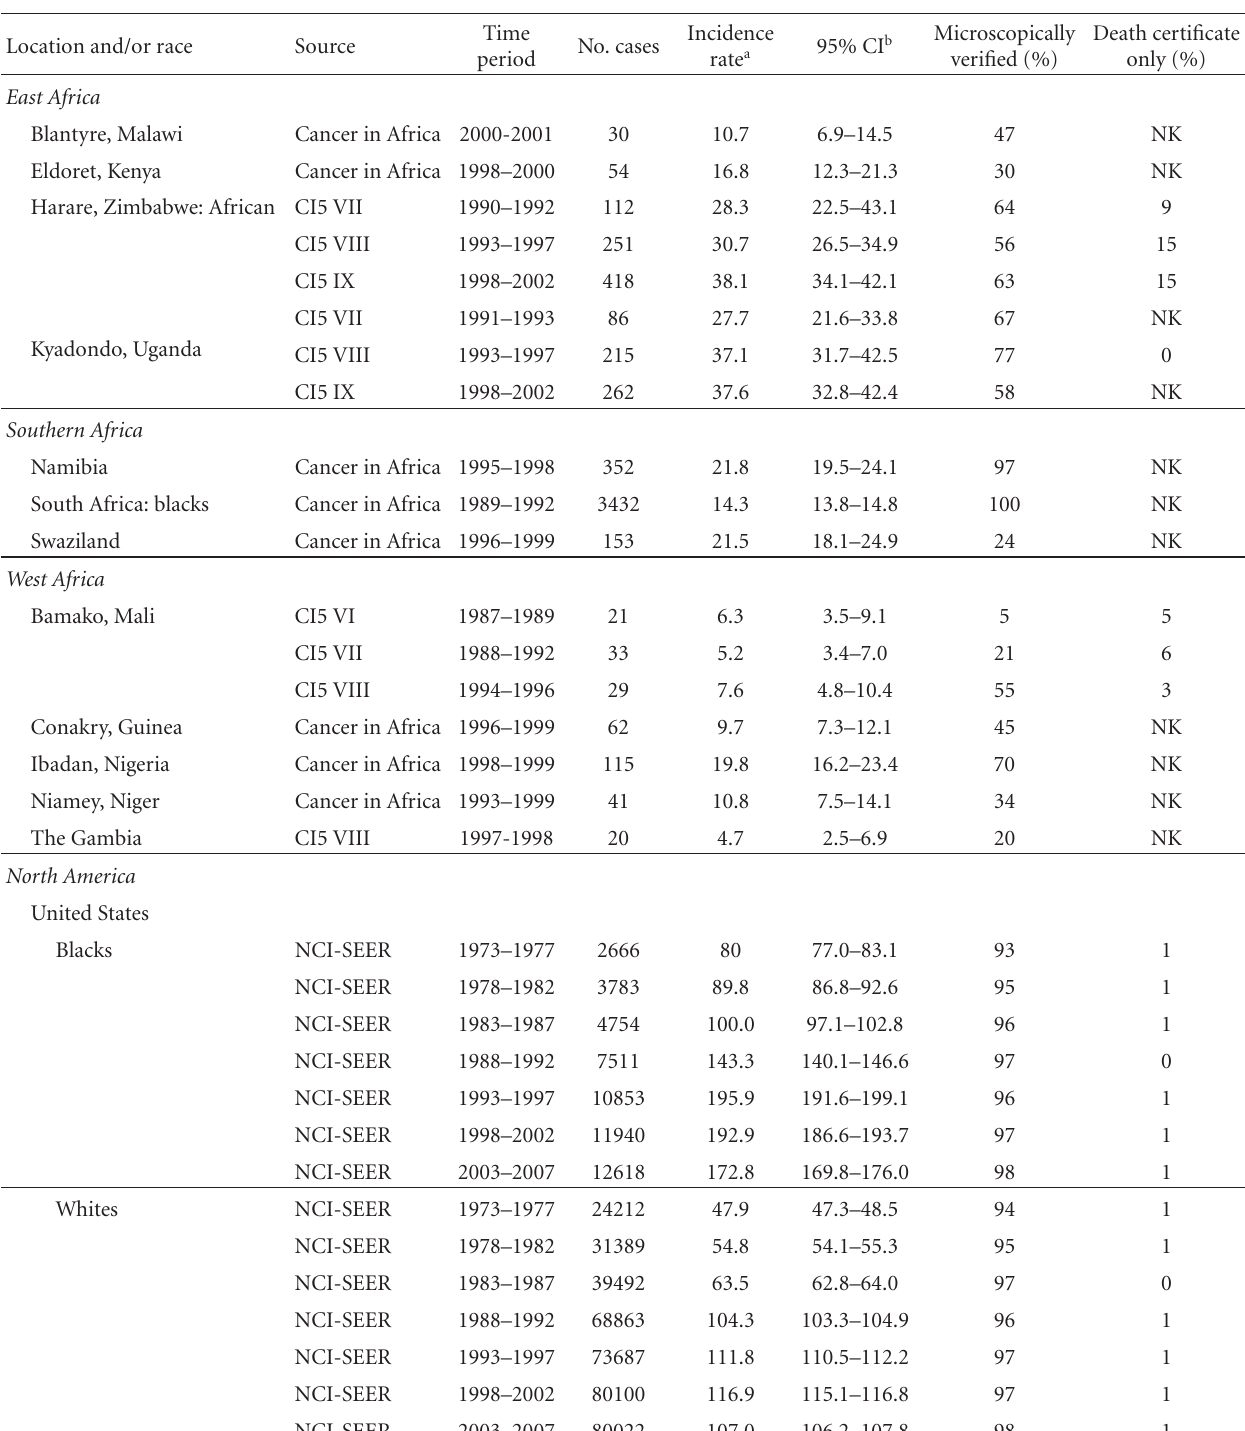
Table 1: Age-adjusted prostate cancer incidence rates a per 100,000 man-years, 95% confidence intervals (CIs), percent microscopically verified, and percent reported by death certificate only in Sub-Saharan Africa and the United States, 1973–2007. Location and/or